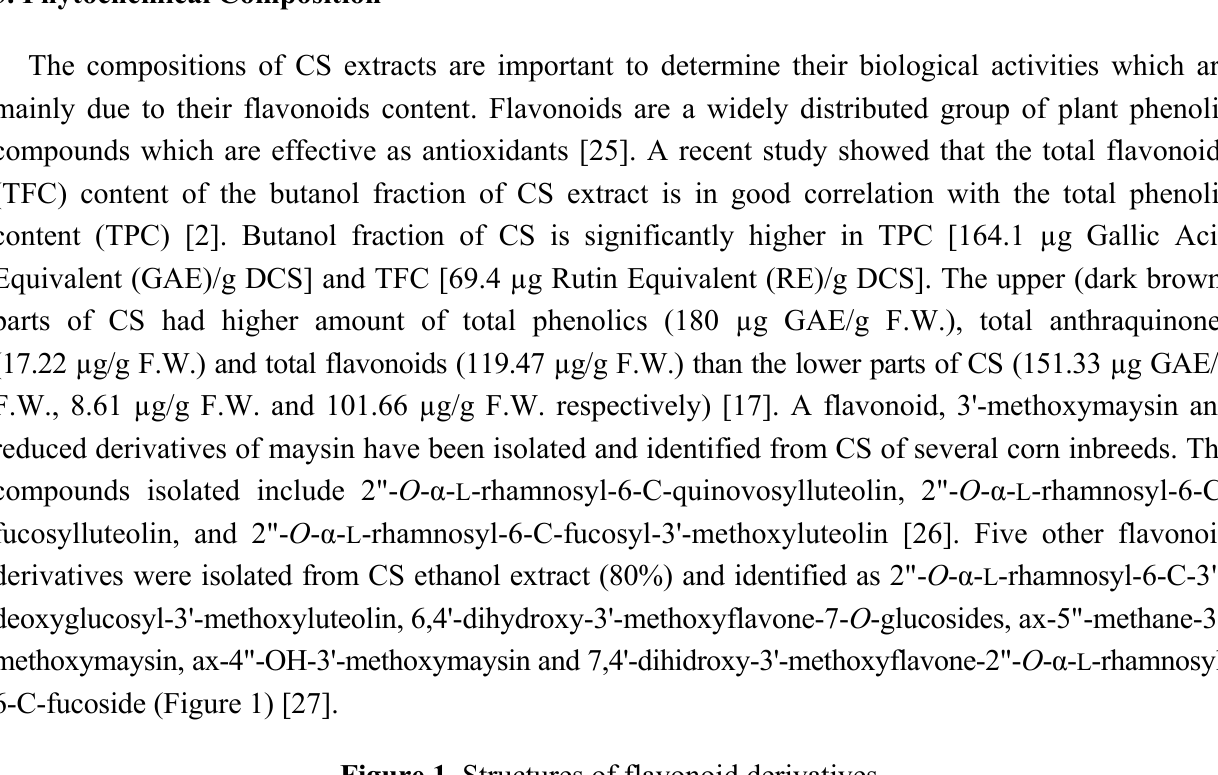
Figure 1. Structures of flavonoid